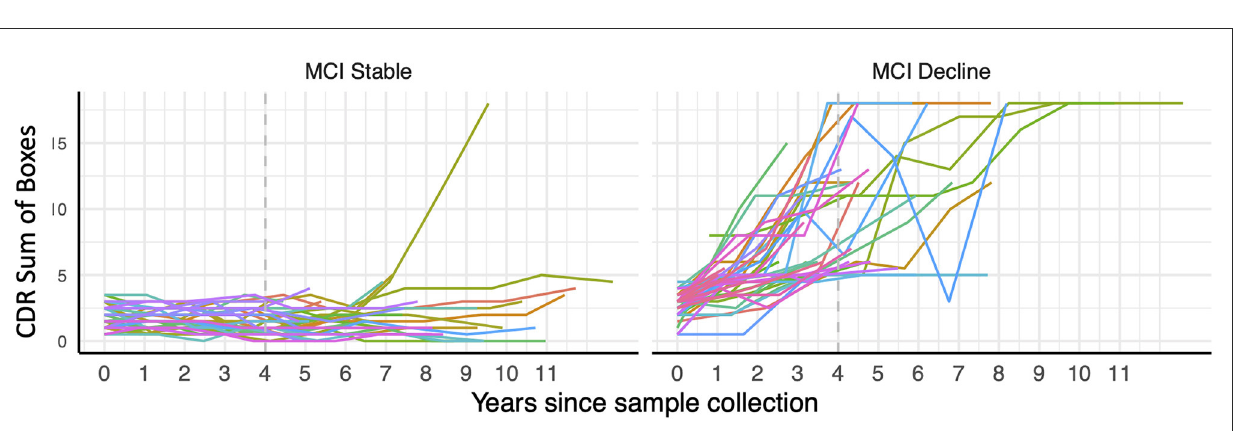
FIGURE2 Trajectory of CDR Sum of Boxes scores over longitudinal visits in participants with mild cognitive impairment (MCI) at the time of blood draw classified as stable or decliners based on their cognitive trajectories during 4 years of follow-up (indicated with dashed gray